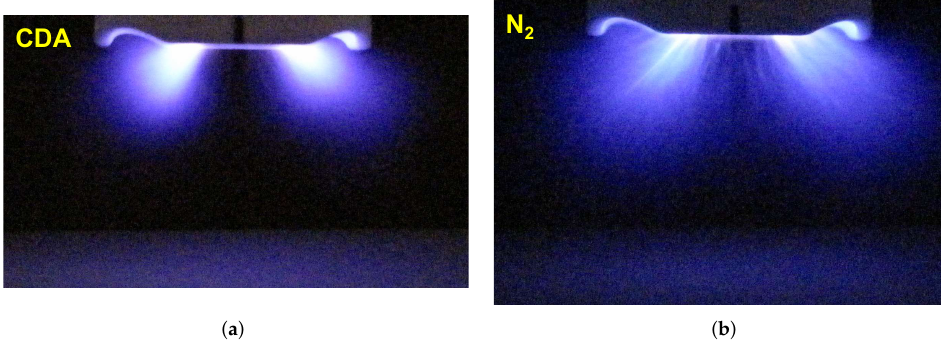
Figure 3. The PDD in ( a ) CDA, the camera exposure time was 1 s, and ( b ) in nitrogen, the camera exposure time was 0.3 s, for PCPG power of 8.0 W, gas flow of 8 SLM, and distance of 20 mm. The lens aperture for both pictures was